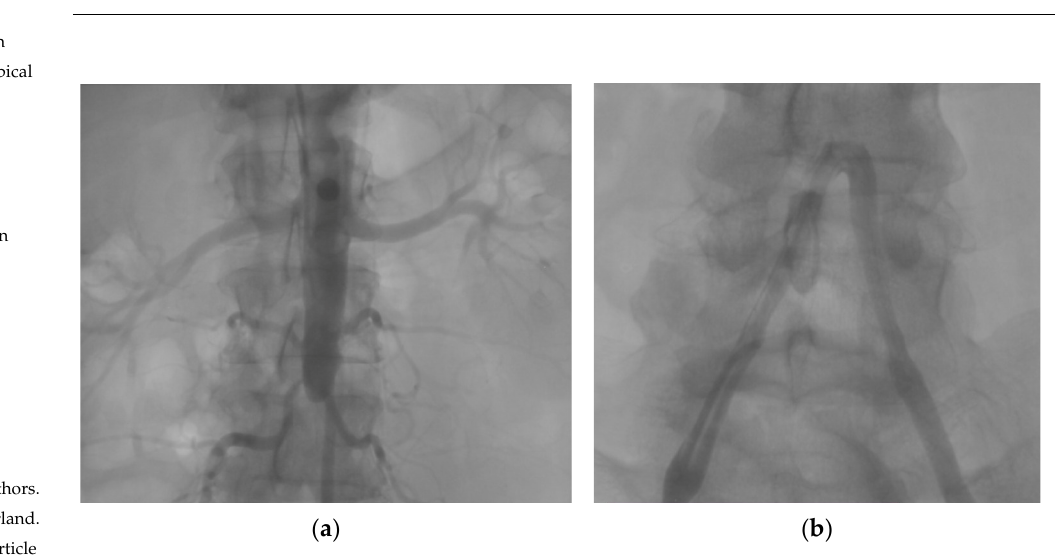
Figure 1. ( a ) Right radial access via pigtail catheter showing complete chronic infrarenal aortic occlusion; renal arteries without lesions—normal opaci fi cation; spinal branches; and one uterine branch with normal opaci fi cation (collateral circulation). ( b ) Right femoral access via multipurpose catheter—common and external iliac arteries with 40–50% atheromatous plaques di ff use in fi ltration (or underperfused); no opaci fi cation of the aorta prior to the aortic bifurcation suggests complete distal aortic occlusion. Arteriography images of the distal abdominal aorta of a 42-year-old female presenting to the Internal Medicine Clinic with bilateral lower limb pain, which proved to have typical intermi tt ent claudication features, are discussed herein. The onset of symptoms was approx- imately fi ve years prior to admission. At that time, the patient was investigated with electromyog- raphy, which had a normal result, and with venous Doppler ultrasound that indicated chronic ve- nous insu ffi ciency. No improvement of the symptoms was registered after the initiation of diosmin and hesperidin treatment. During the last two years, paresthesia of the lower extremities added to the initial symptoms. A lumbar spine MRI showed only moderate osteoarthritis changes, with no spinal stenosis and no disco-radicular con fl icts. The patient—a smoker of 15 pack-years—was known to have mixed dyslipidemia, and her body mass index fell within class I obesity values. At the age of 19, she had a pregnancy complicated by pre-eclampsia, but with a full-term birth, and was consequently diagnosed with essential arterial hypertension after the exclusion of secondary high blood pressure causes. Her blood pressure has been kept under control ever since with angio- tensin-II-receptor antagonist therapy (candesartan). The medical history of the patient also included one spontaneous abortion in the ninth week of pregnancy and one fetal death in the twelfth week of pregnancy. The absence of bilateral peripheral pulses (of the dorsalis pedis artery, posterior tibial artery, popliteal artery, and femoral artery) was noted during the physical examination. The per- formed ankle-brachial index had an equal bilateral value of 0.54, suggestive of severe peripheral arterial disease. The patient had a complete blood count within normal range (8200 white blood cells/mm 3 , 3390 lymphocytes/mm 3 , 269,000 platelets/mm 3 , and 14.2 g/dL hemoglobin), normal levels of in fl ammatory markers (erythrocyte sedimentation rate 18 mm/h and C reactive protein 3 mg/L— normal level < 5 mg/L), with dyslipidemia being the only alteration of blood tests (total cholesterol 205 mg/dL and triglycerides 168 mg/dL). Considering the obstetric history of the patient, an immu- nological work-up was carried out. The results indicated negative antinuclear antibodies, negative anti-double-stranded DNA antibodies, negative anti-beta-2-glycoprotein antibodies, negative anti- La antibodies, negative anti-Ro antibodies, negative anti-Sm antibodies, negative lupus anticoagu- lant factor, negative anti-cardiolipin IgG antibodies, weakly positive anti-cardiolipin IgM antibodies (24 MPL/mL, normal values < 20 MPL/mL), and negative antineutrophil cytoplasmic antibodies (c- ANCA, p-ANCA). An arterial Doppler exam of lower limb vessels showed di ff use changes in arte- rial waveform and a lack of Doppler signal in the anterior tibial artery, bilaterally. No atheroma, stenoses or thromboses were found. The patient was referred to the cardiology clinic for further investigation. She underwent arteriography, and the result emphasized the presence of a fi ve-centi- meter complete infrarenal aortic occlusion that did not involve the aortic bifurcation (this fi gure). The presence of collateral arteries between the lesser pelvis and the internal and external iliac arter- ies was noticed. The angiography could not demonstrate an atherosclerotic or thrombotic etiology of the complete distal aortic occlusion.